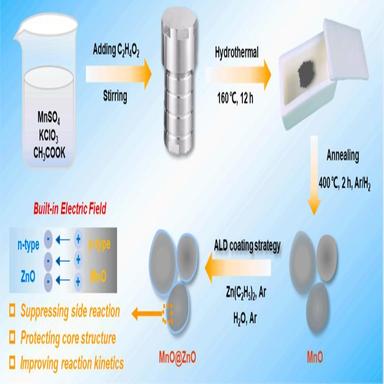
Characterization of MnO and MnO@ZnO particles. (a) SEM image of MnO, (b, c) SEM images of MnO@ZnO, (d–f) TEM images of MnO@ZnO, (g) HRTEM image of MnO@ZnO, inset showing the corresponding SAED pattern, (h) EDS of MnO@ZnO, (i) HAADF-STEM image and corresponding EDS mappings of MnO@ZnO, and (j) Atomic fraction in MnO@ZnO.